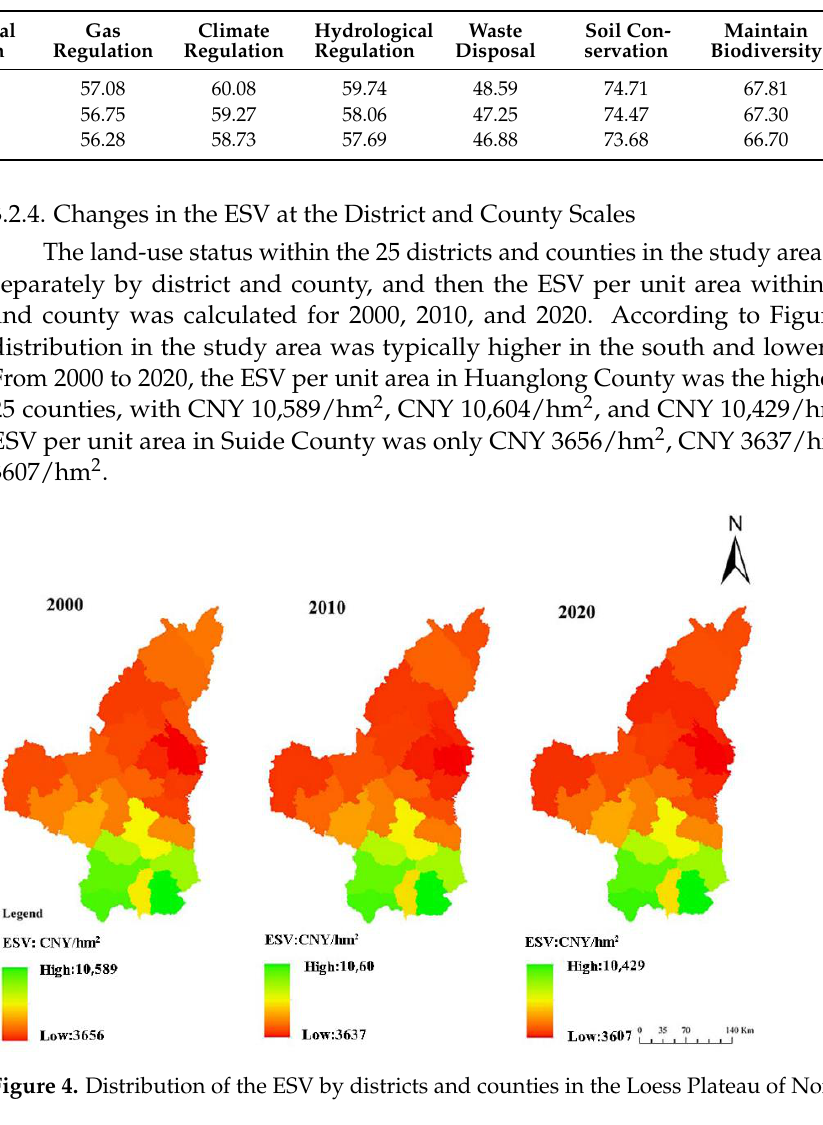
Figure 5. Changes in the ESV by districts and counties in the Loess Plateau of Northern Shaanxi. 3.3. The Spatial Distribution Pattern of the ESV 3.3.1. Global Spatial Autocorrelation Analysis Scatter plots of Moran ’ s I index for 2000, 2010, and 2020 were obtained by means of global spatial autocorrelation analysis (Figure 6). Figure 6 shows that the global Moran ’ s I indexes for the ESV per unit area in 2000, 2010, and 2020 for 25 districts and counties in